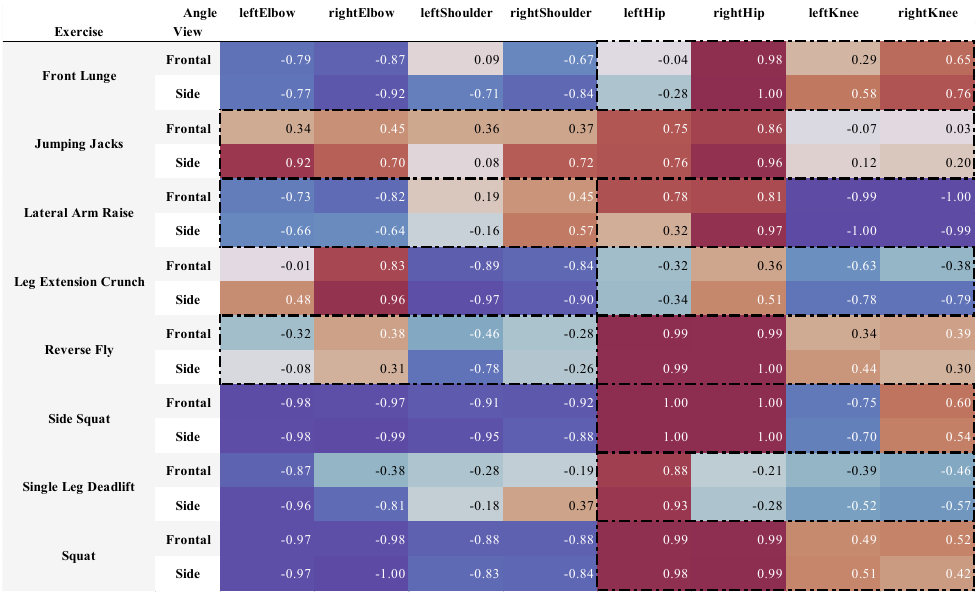
Figure A4. Pivot Table of the ratio of the ME divided by the MAE distributed over the eight exercises and the eight tracked angles, each measured from the two iPad perspectives Frontal and Side . The dashed boxes indicate which joints were specifically targeted by the respective exercise. The heatmap visualizes the performance of the individual joints per exercise. Values close to zero indicate either good performance of the tracking or over- and underestimation canceling each other out. Values closer to − 1 and 1 hint at systematic under- and overestimation in the specific